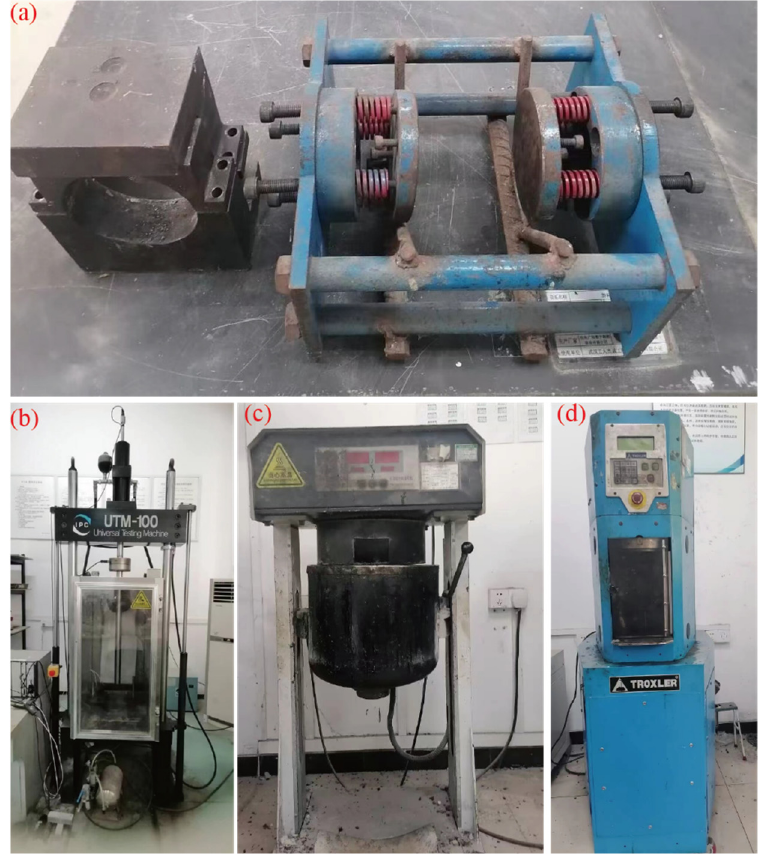
Figure 1. Experimental equipment: ( a ) a shear test fixture for applying vertical force; ( b ) multifunction testing machine UTM-100; ( c ) asphalt mixture mixer; ( d ) SGC (Superpave Gyratory Compactor).